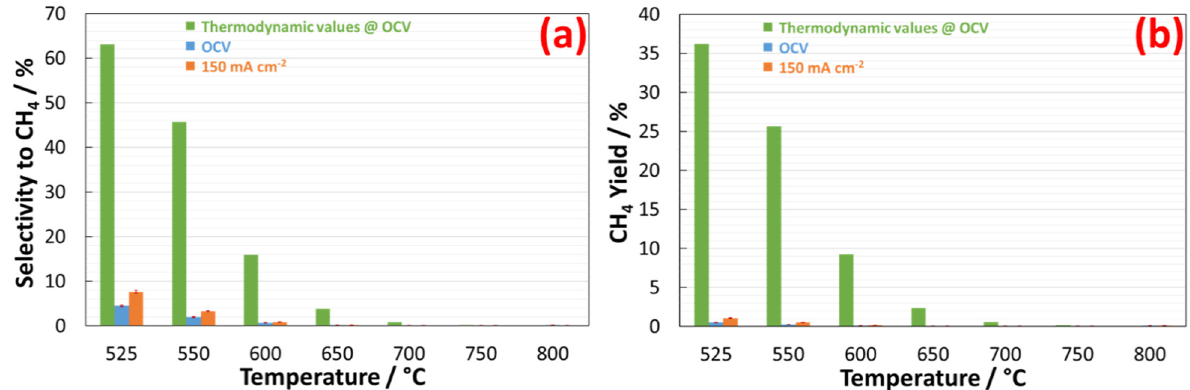
Figure 5. Trend of CH 4 selectivity ( a ) and yield ( b ) treated according to Equations (7) and (8).